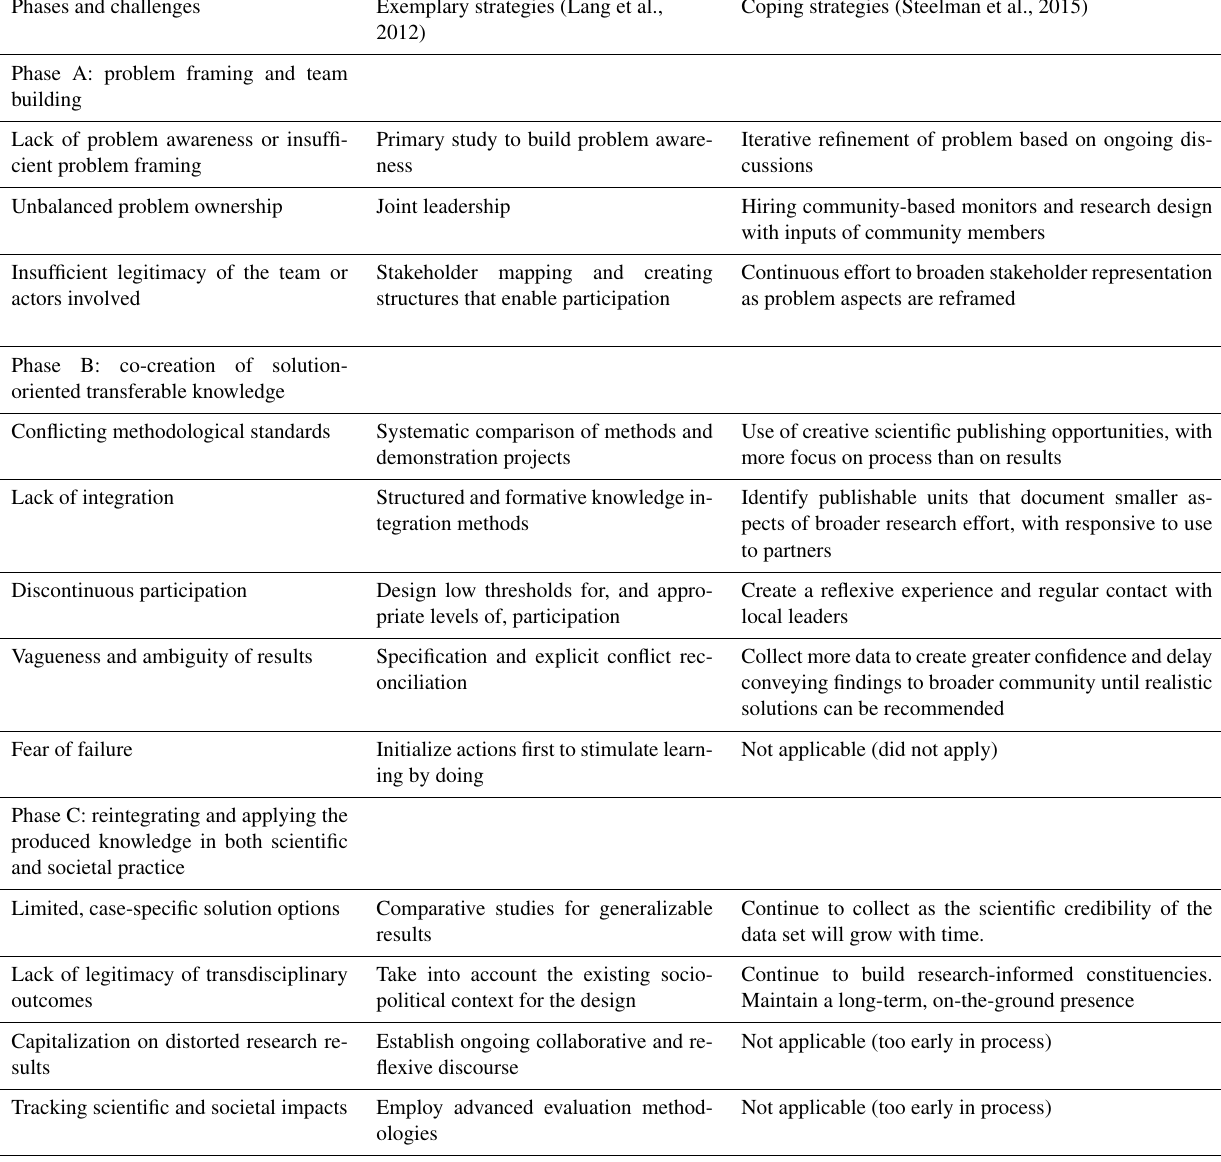
Table 1. Challenges and strategies in transdisciplinary water research (source: Lang et al., 2012; Steelman et al., 2015). Phases and challenges Exemplary strategies (Lang et al., Coping strategies (Steelman et al., 2012)